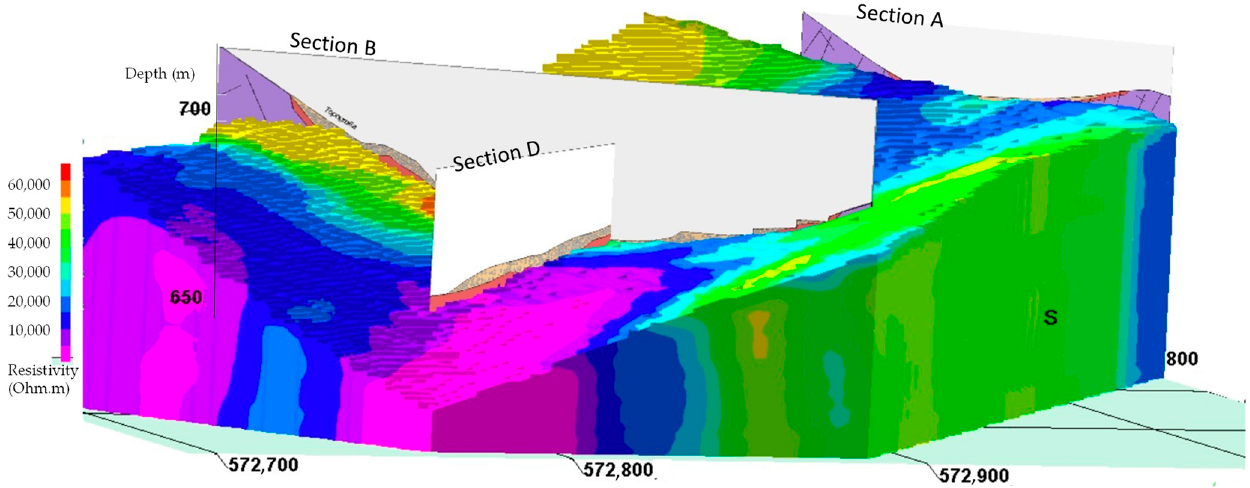
Figure 14. 3D visualization of the model of electrical resistivities and interpreted geological sections.